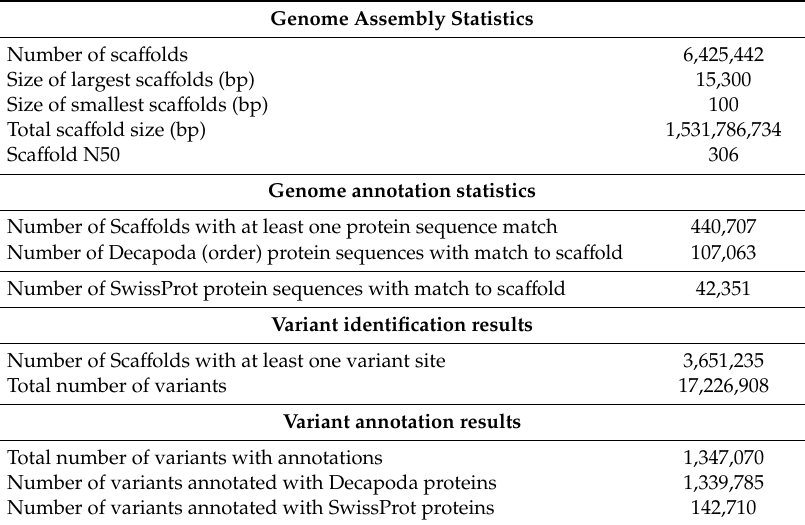
Table 2. Summary of the genome assembly, genome annotation, variants identifications and variant annotation results obtained from the skim sequencing (SkimSeq) data of Penaeus monodon broodstock population collected from di ff erent Indo-Pacific regions.